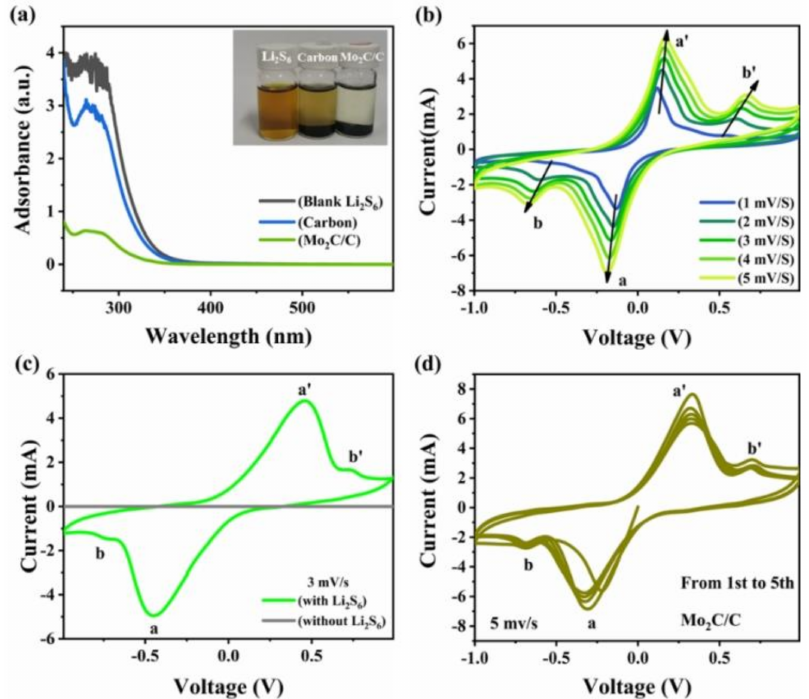
Figure 3. ( a ) UV–vis spectra of the supernatant after adsorption of Li 2 S 6 solutions by different adsorbents. Inset: Digital photo of the corresponding Li 2 S 6 solutions. ( b ) CV curves of the symmetric battery with the Mo 2 C/C as electrodes and Li 2 S 6 solution as an electrolyte at various scan rates. ( c ) CV comparison of symmetric cells assembled with the conventional electrolyte and Li 2 S 6 solution and Mo 2 C/C electrodes at 3 mV s − 1 . ( d ) CV cycling curves of the symmetric cell with Mo 2 C/C electrodes at 5 mV s − 1